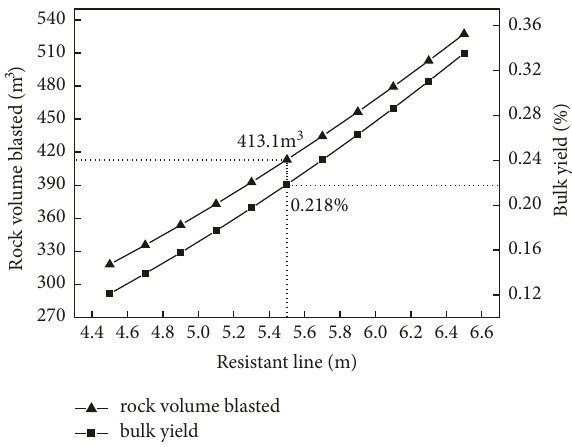
Figure 16: Blasting quality and mining cost.